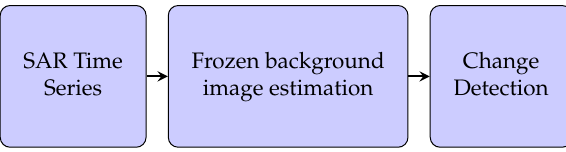
Figure 2. Frozen background reference (FBR) based change detection (CD) using Synthetic Aperture Radar (SAR) time-series.